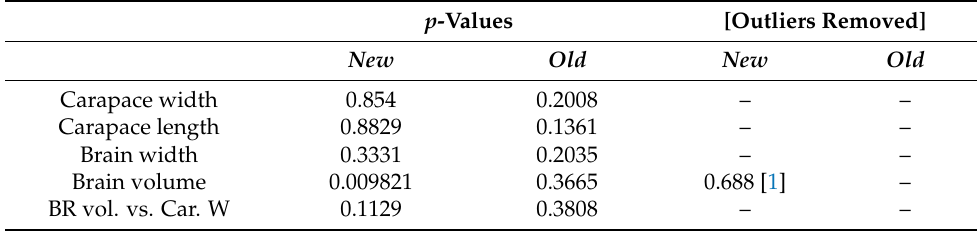
Table 2. Results of normality test. p -Values [Outliers Removed] New